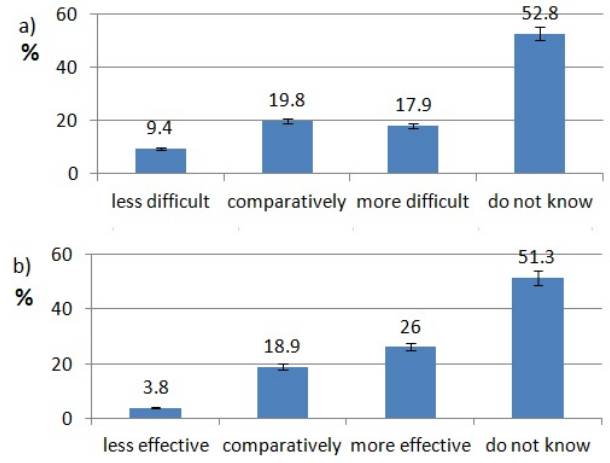
Figure 8. Pulp vitality tests use pattern of responding dentists; ( a ) effectiveness of pulp vitality tests, ( b ) difficulty of pulp vitality tests.